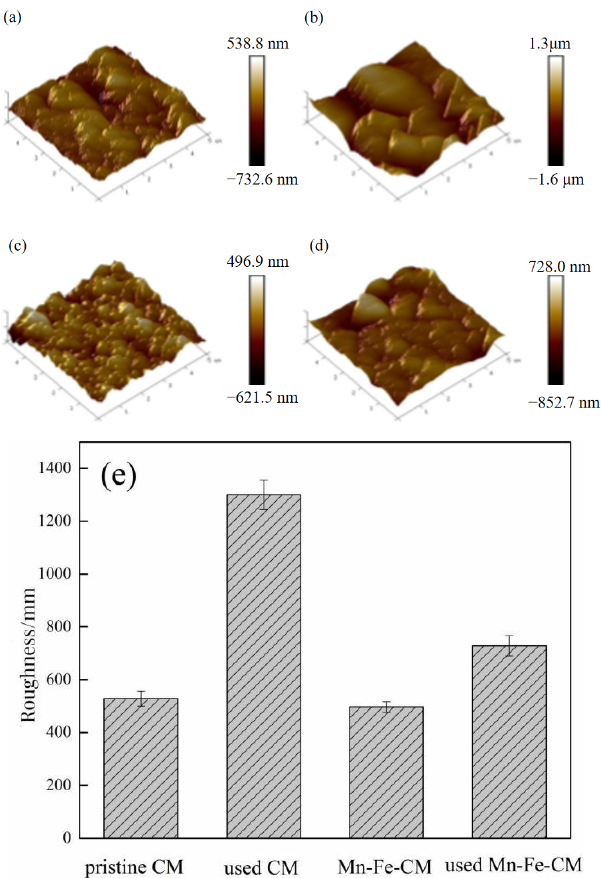
Figure 7. AFM characterization of ceramic membranes before and after use in the combined process: ( a , c ) CM and Mn-Fe-CM before use; ( b , d ) CM and Mn-Fe-CM after use, ( e ) roughness variation. Table 2. Removal performance and membrane fouling change in different ozonation-ceramic mem- brane filtration systems.